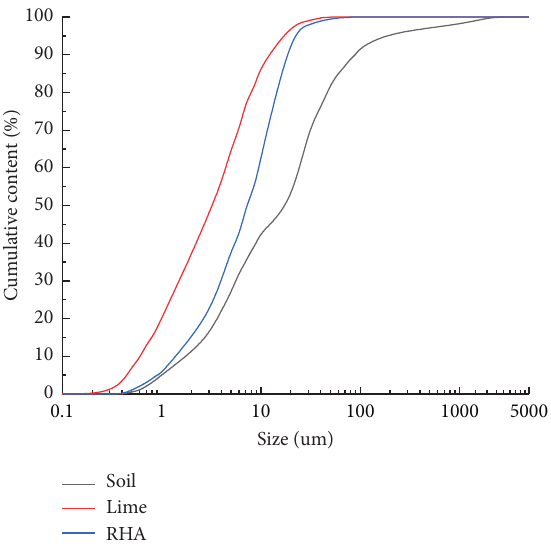
Figure 3: The grain composition of raw materials.